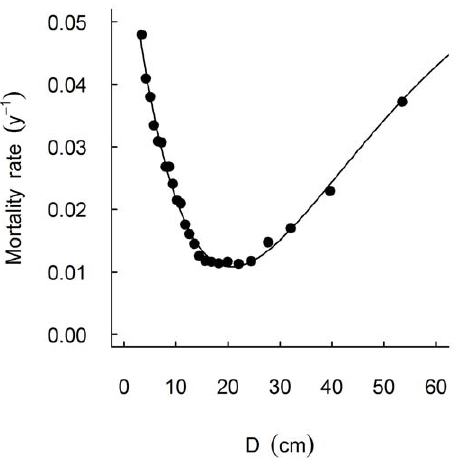
Figure 2. Size-specific mortality pattern over the 30-year study period, 1974–2004. Points represent the observed annual mortality rates, in size-class bins, plotted against the mean diameter (D) of stems in that size class. There were initially 19 515 trees alive in 1974, of which 9111 had died by 2004. Size-class bins each contained 1000 individuals, except for the largest size-class bin which contained 515 individuals. The line was fitted using the function: m=a + bD e cD , where a=0.0680, b= 2 0.000752 and c= 2